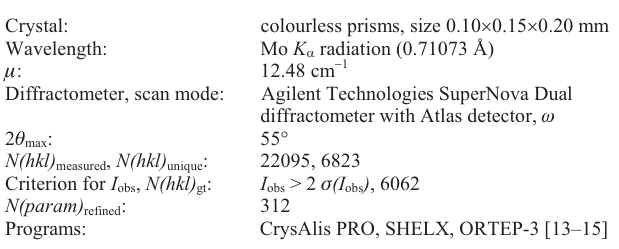
Table 1. Data collection and handling.